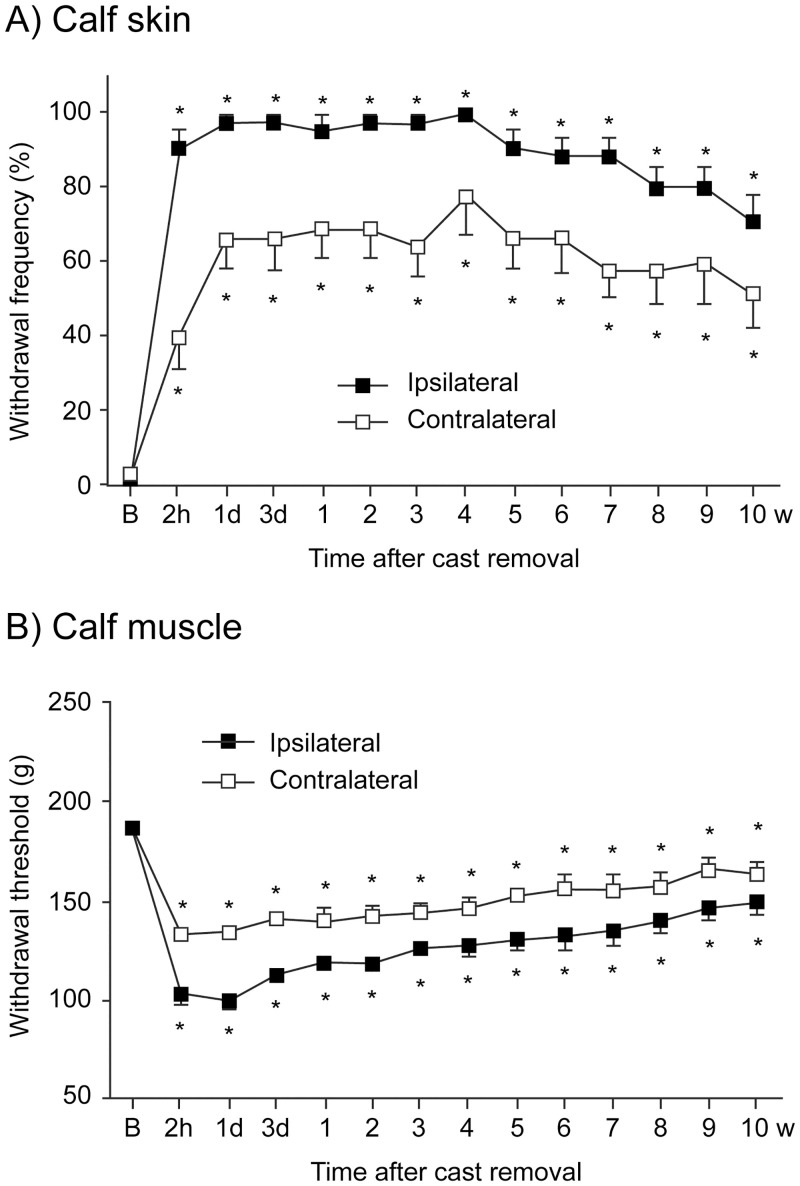
Time course of changes in mechanical allodynia in the calf skin and calf muscles of Chronic Post-Cast Pain (CPCP) rats.The frequency of withdrawal responses to a von Frey filament on the calf skin (A) and the withdrawal threshold to pressure stimuli on the calf muscle (B) in CPCP rats are shown (mean ± SEM, n = 9). The measurement time points are indicated on the horizontal axis (B, before cast application; h, hour; d, day; w, week). *p < 0.05 versus values before cast application (one-way ANOVA and post hoc Dunnett’s tests).